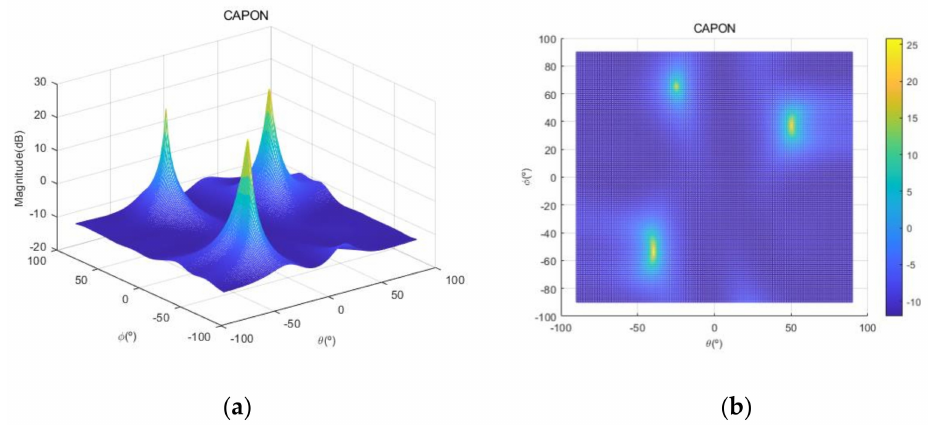
Figure 15. Comparison of the proposed cascade algorithm, MUSIC, and only Beamspace MUSIC, for the third scenario.